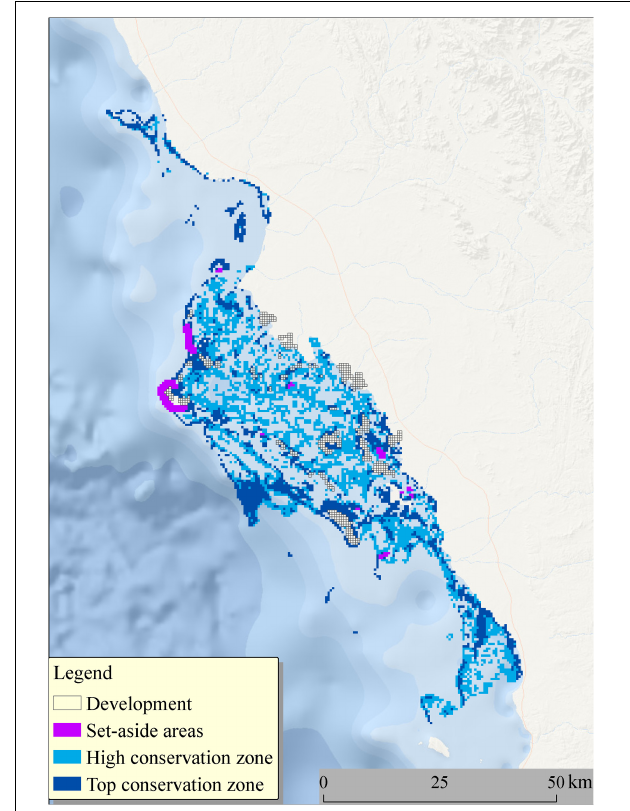
FIGURE 4 | Preliminary zoning of the site. The deep blue grid cells constitute the “top conservation zone , ” the light blue grid cells form the “high conservation zone , ” the gray grid cells create the “development zone , ” and the purple grid cells are the set-aside islands which are part of the “top conservation zone . ” All the rest are non-allocated